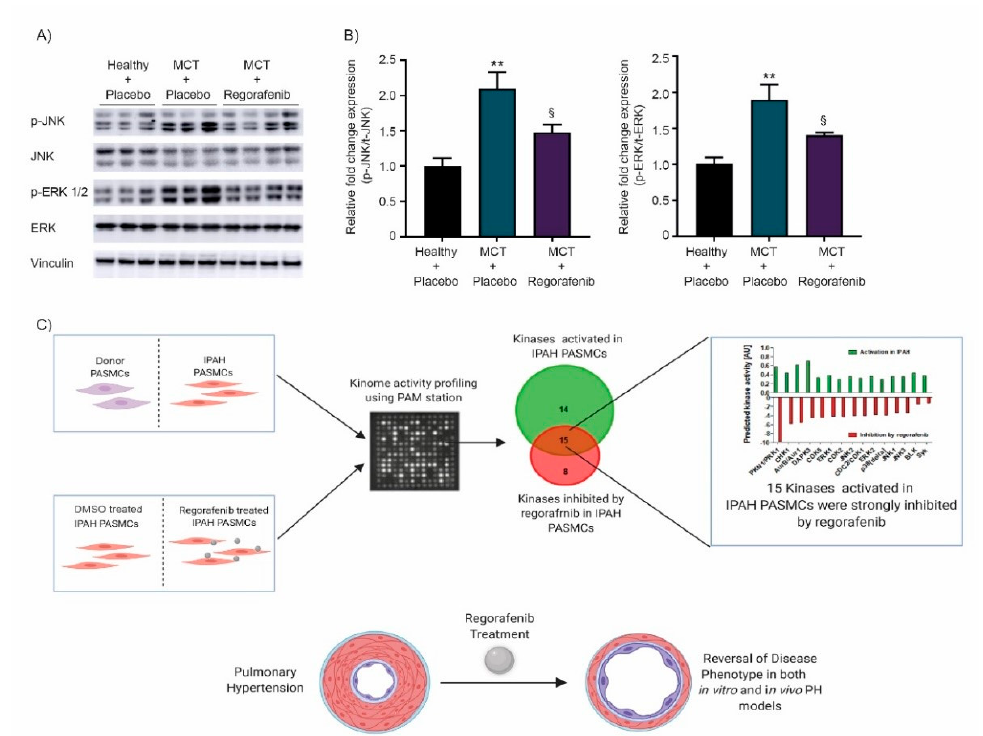
Figure 5. Effect of regorafenib on c-Jun N-terminal kinase (JNK) and extracellular signal-regulated kinases (ERK) and mitogen-activated protein kinases (MAPK) signaling in the MCT model. ( A ) Western blots representing p-JNK, t-JNK, p-ERK1/2, and t-ERK. Vinculin serves as a loading control. ( B ) Densitometric analysis showing relative fold activity of p-JNK/t-JNK and p-ERK/t-ERK ( n = 3–4 per group). ** p < 0.01 versus healthy + placebo; § p < 0.05 versus MCT + placebo. Data represent the mean ± SEM. ( C ) Schematic representation of the regorafenib mode of action in PH (created with BioRender.com).